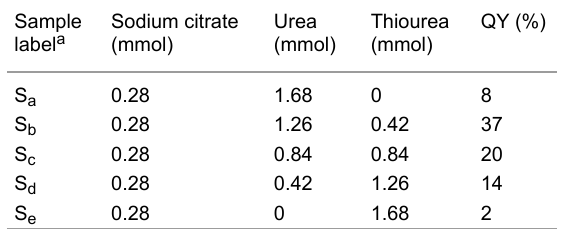
Table 1: Fluorescent carbon nanodots with different quantum yields synthesized using different